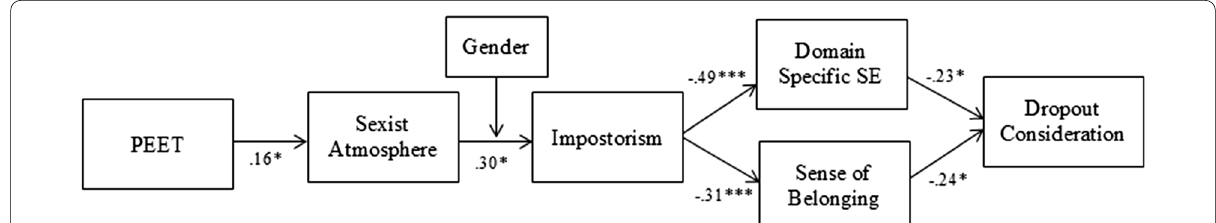
Fig. 2 Model of differential impact of perceived environmental entity theory (PEET) on consideration of dropping out STEM graduate program by gender with standardized path coefficients. Fit indices indicated good model fit (χ 2 [21] < 0.05, ** p < 0.01, *** p <